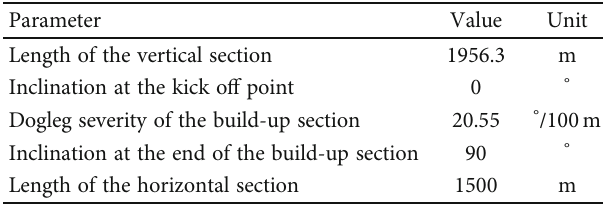
Figure 5: An open pipe string with an impermeable cutting plug. Table 1: Trajectory data of the horizontal well.